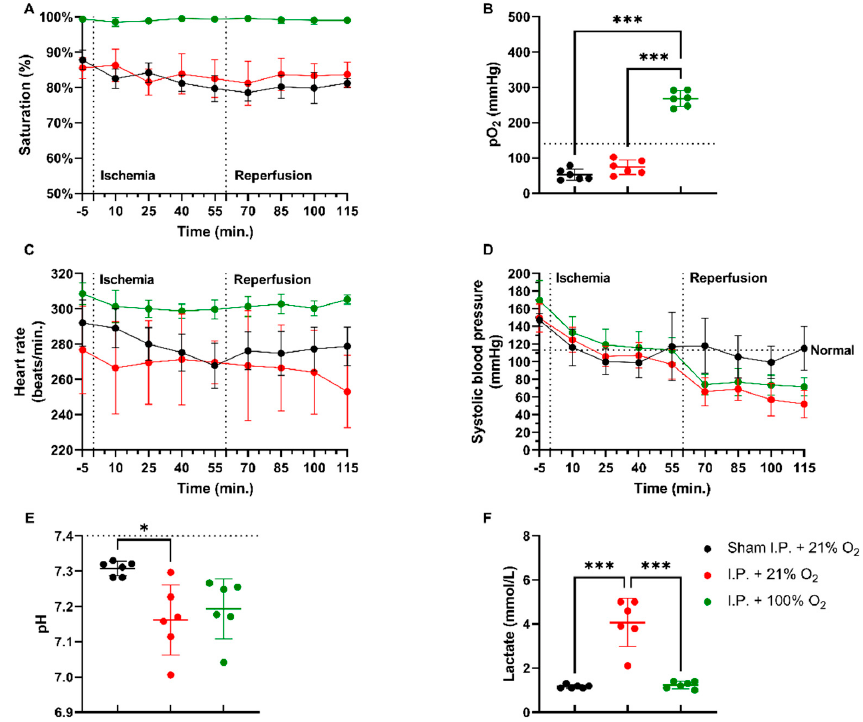
Figure 1. Hemodynamic changes were monitored throughout the 60 min of ischemia and 60 min of reperfusion. The impact of oxygen supplementation was assessed on saturation ( A ), partial oxygen pressure (pO 2 ) ( B ), heart rate ( C ), and systolic blood pressure ( D ). After 60 min of reperfusion, arterial blood gas analysis revealed important pH ( E ) and lactate ( F ) changes. ( n = 6/group). I.P.: intraperitoneal injection anesthesia; O 2 : oxygen. Normal values are shown by a horizontal dashed line in graphs ( C , D ). Onset of ischemia and reperfusion are shown by vertical dashed lines in graphs ( A – C ). * p < 0.05; *** p < 0.001.